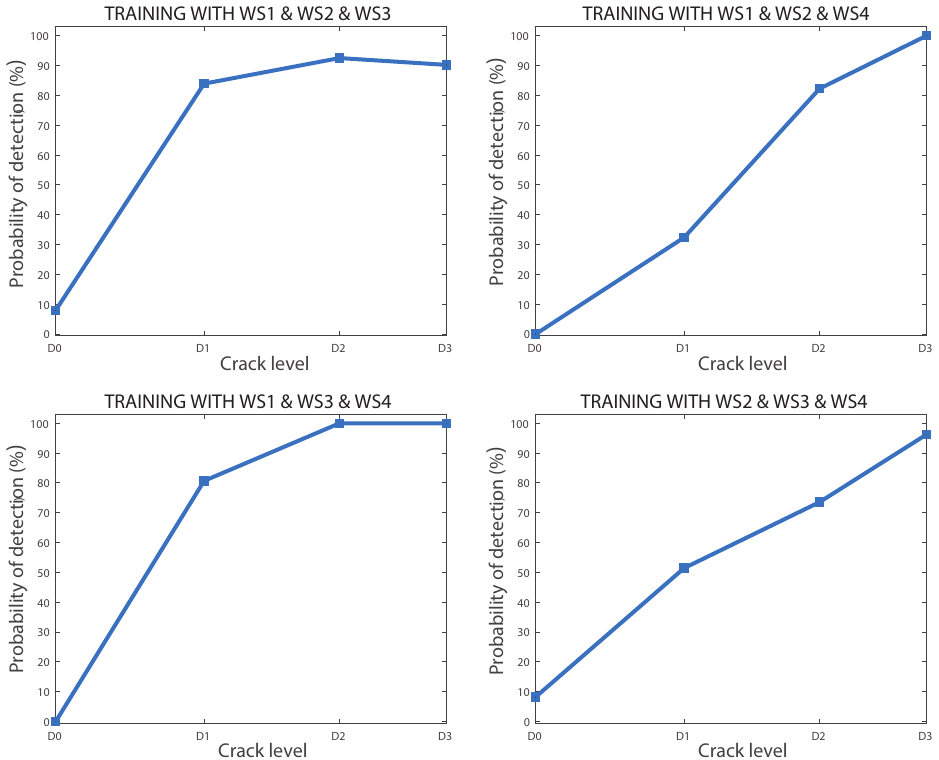
Figure 12. Probability of detecting a crack (%) for each crack size for all models where the data from three wheelsets were used for